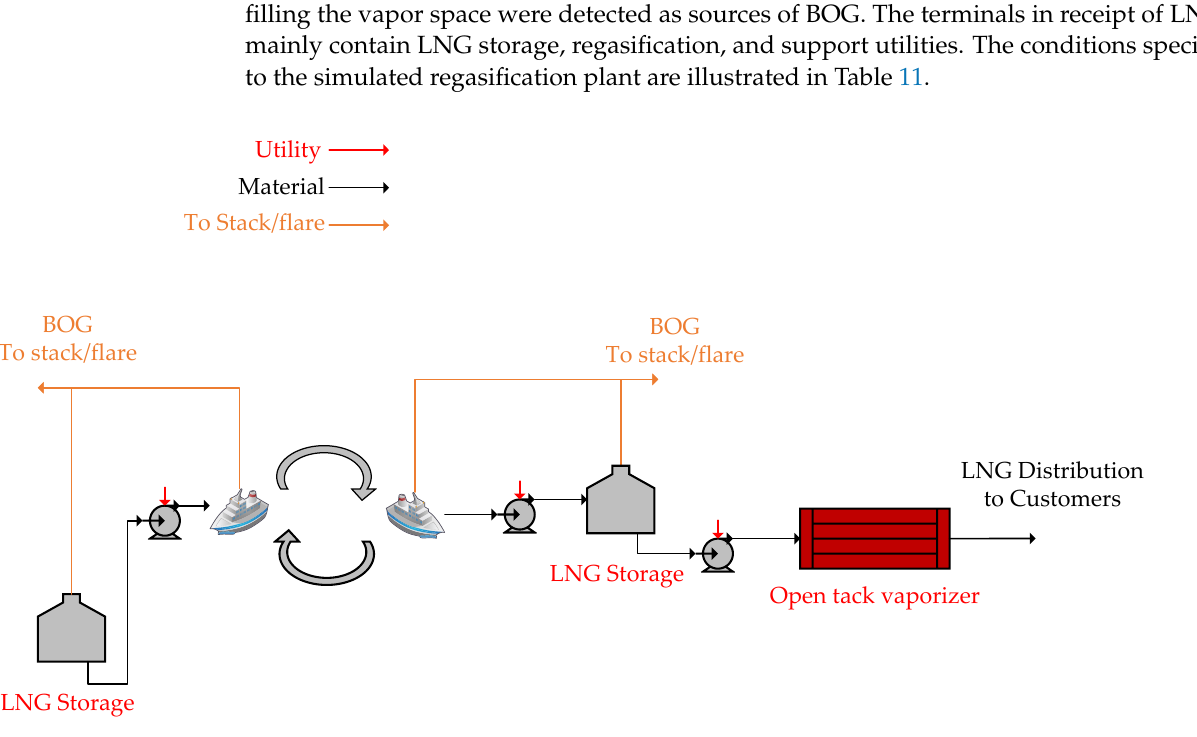
Figure 12. PFD of the export LNG loading, import terminal, and regasification plant. Table 11. Regasification plant conditions and